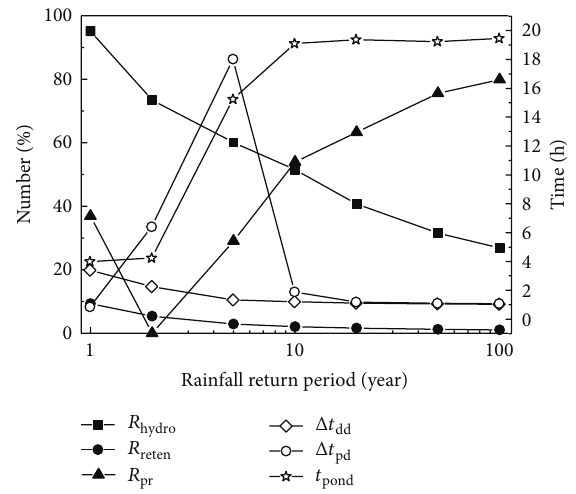
Figure 5: Hydrologic performance of bioretention measures under rainfalls with different return periods.